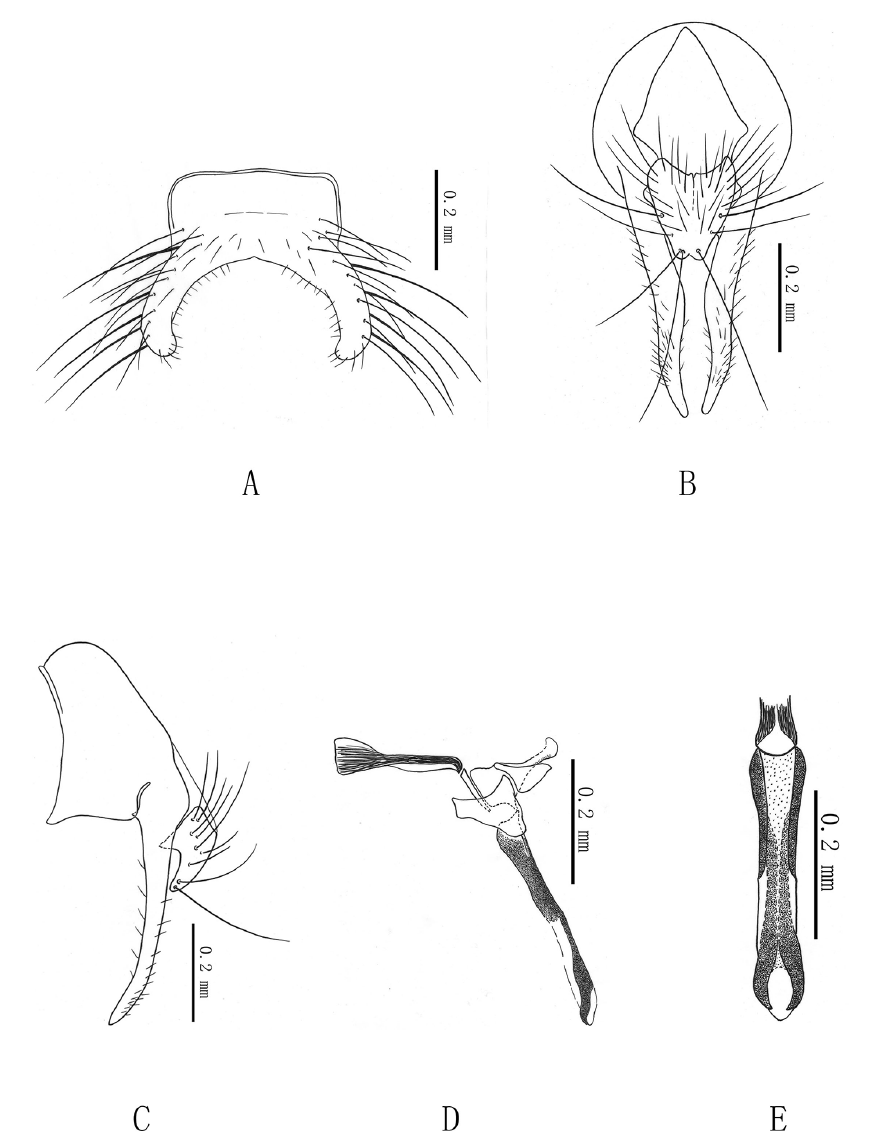
Figure 3. Delia nigerihalteres sp. n. A male, 5 th sternite in ventral view; B. male, terminalia in poste- rior view; C. male, terminalia in profile; D. male, aedeagus in profile; E. male, distal part of aedeagus in anterior